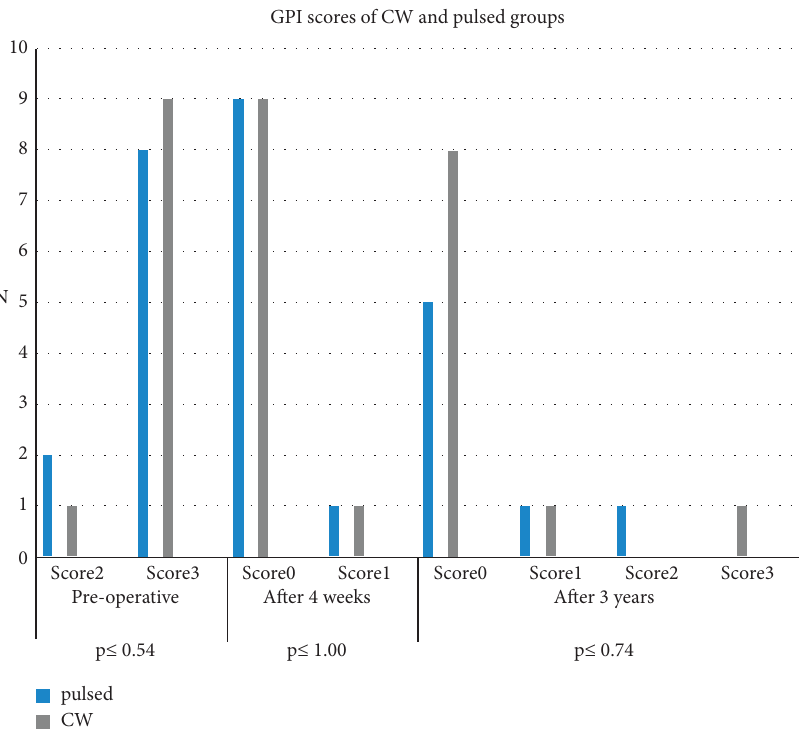
Figure 3: Te GPI scores of the CW and pulsed groups at three follow-up time